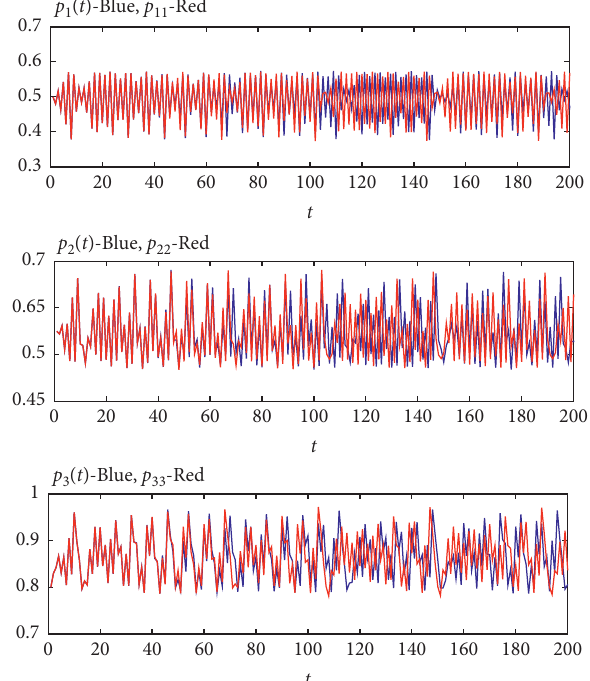
Figure 8: Sensitivity analysis of the nonlinear dynamic system (12) corresponding to the initial